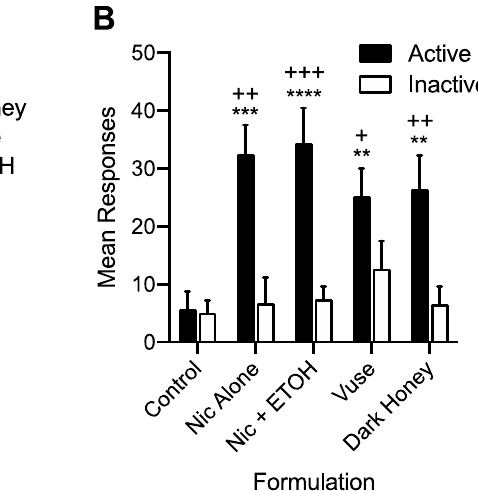
Figure 1. Mean (± the standard error of the mean (SEM)) number of infusions earned per session during the first 10 sessions of the acquisition of self-administration (SA) (panel A ) and at stability under the FR 1 schedule prior to demand assessment (panel B ). Each point or bar represents the mean of 9 – 21 rats. Control is the combined mean of the groups with access to saline alone or saline + ETOH, which did not differ from each other. Because responses during the timeout are not included, the number of active lever responses is equal to the number of infusions for each formulation. Different from Control, * p < 0.05, ** p < 0.01, *** p < 0.001, **** p < 0.0001. Different from Dark Honey † p < 0.05, †† p < 0.01. Panel A : Different from Vuse + p < 0.05. Panel B : Different from Inactive + p < 0.05, ++ p < 0.01, +++ p < 0.001.